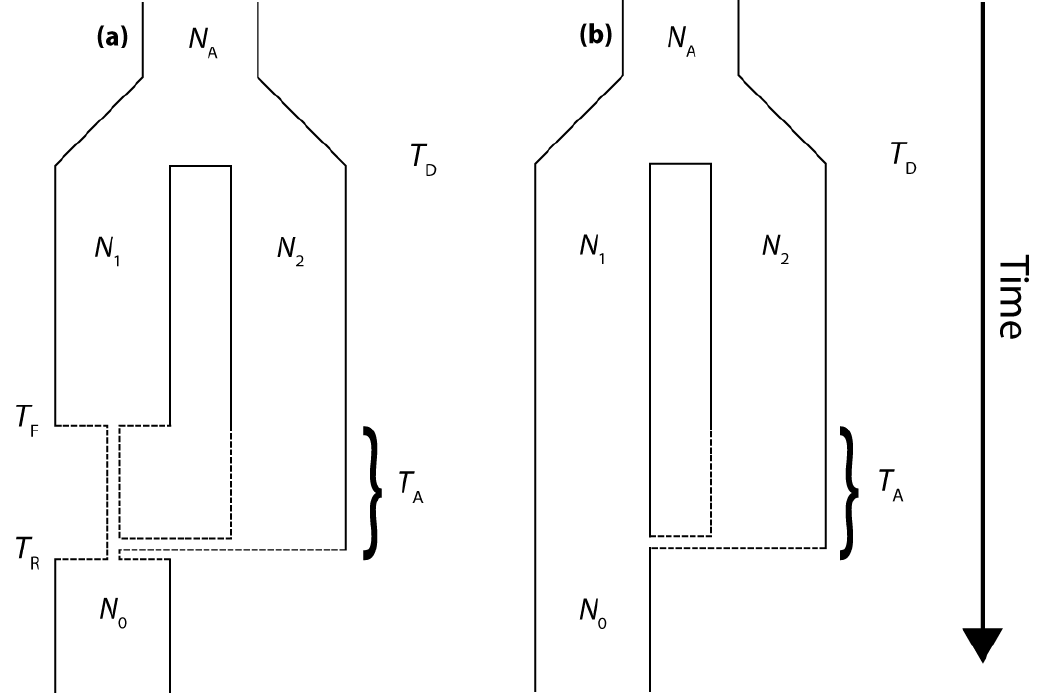
Figure 1. (a) The Isolation-and-Admixture (IAA) model with a founder event, (b) the IAA model with constant population size. See Table 1 for a detailed explanation of model